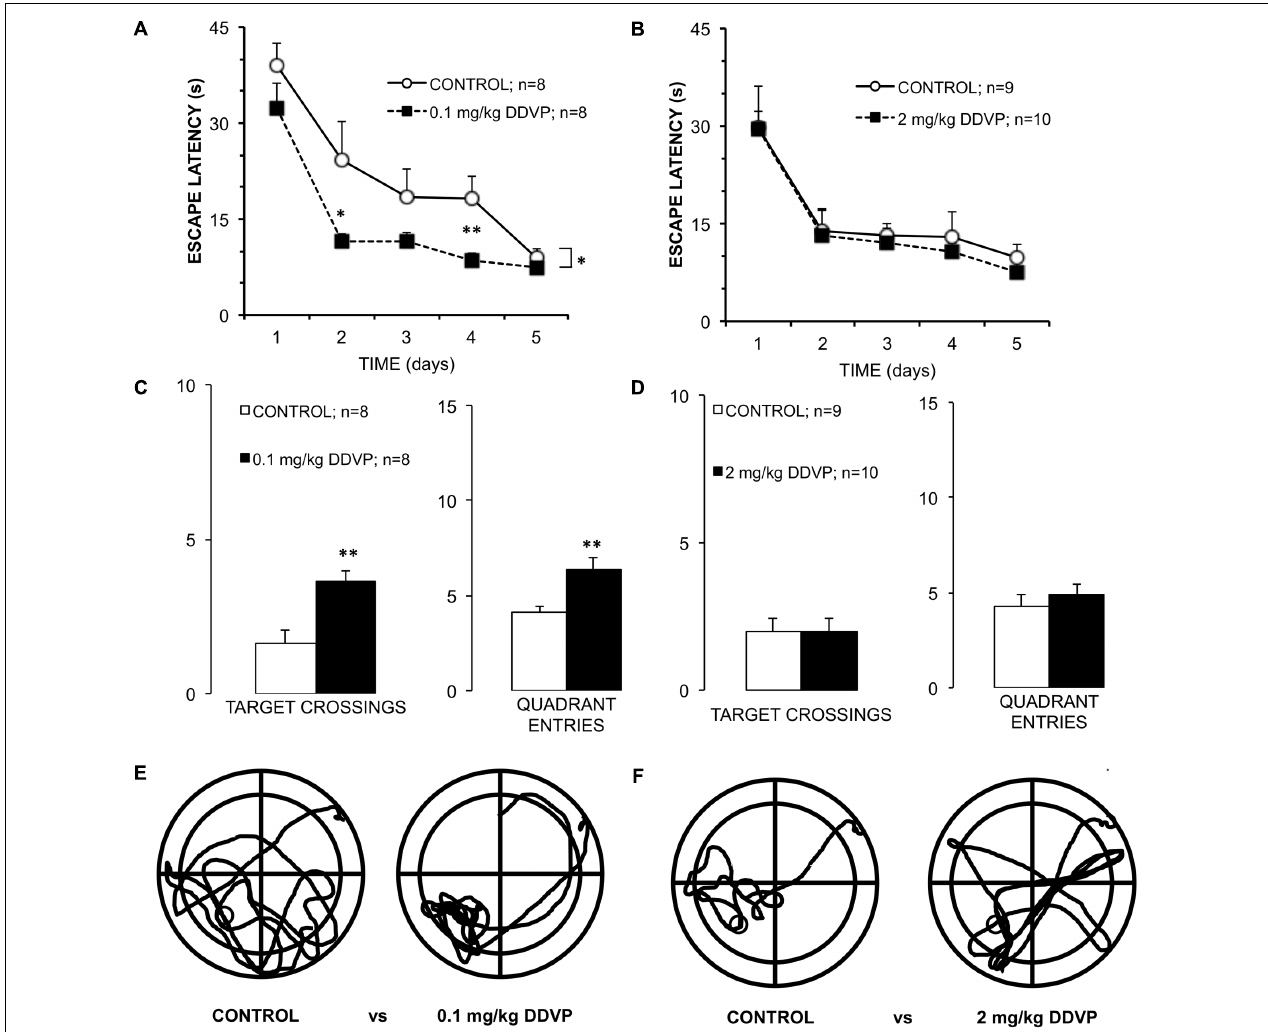
FIGURE 3 | Differential effects of low and high DDVP doses on learning and memory. (A,B) Graphs of the escape latency (time to reach the submerged platform) for groups of rats treated with (A) 0.1 mg/kg DDVP (black squares), (B) 2 mg/kg DDVP (black squares), and their control groups (open circles). Rats treated with the low DDVP dose showed an improved escape latency starting from the 2nd day of training. (C,D) Results of the memory tests performed 24 h after the learning test. (C) Rats treated with 0.1 mg/kg DDVP (black columns) showed a significantly higher number of target crossings and quadrant entries compared to (D) rats treated with 2.0 mg/kg DDVP (black columns), which did not show significant differences with respect to the controls. (E,F) Representative trajectories of rats swimming for each set of conditions. Rats treated with 0.1 mg/kg DDVP showed improved escape latency and quickly found the platform location. ∗ p < 0.05, ∗∗ p < 0.01. See the text in Results section for